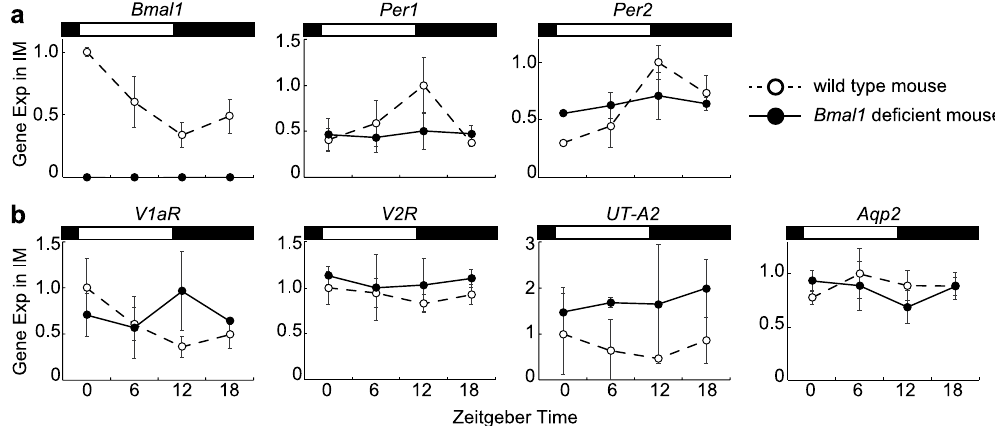
Figure 4. Diurnal variations of clock gene expressions ( a ) and diurnal variation of UT-A2 , Aqp2 , V1aR , and V2R ( b ) in the IM. Data obtained from Bmal1 deficient mouse ( • ) and age matched wild type mouse ( ◦ ) are shown. Data were normalized to 18S ribosomal RNA (mean values ± S.D, n = 3). White and black rectangles in graphs indicate light phase and dark phase,